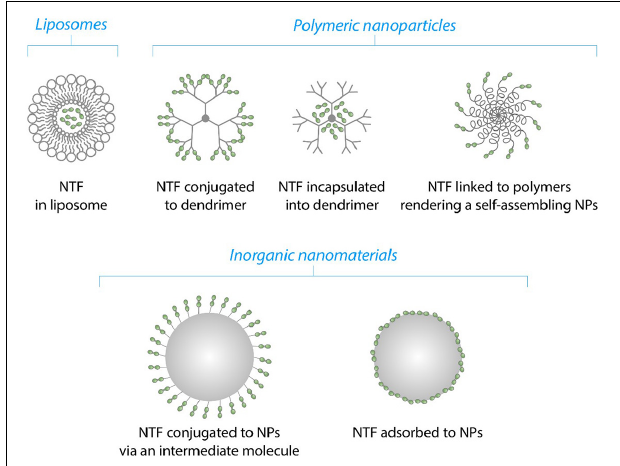
FIGURE 5 | Schematic illustration of the mechanisms of NTFs’ (green dots) binding to